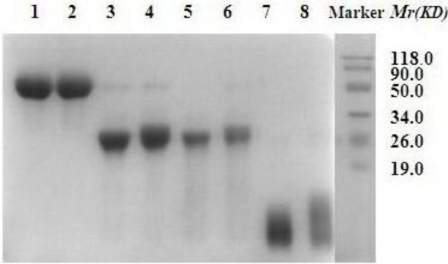
SDS-PAGE analysis of PEGylated HM-3. Lane Marker, Molecular weight markers; Lane 1, SDS-PAGE of SC-mPEG20k; Lane 2, SDS-PAGE of SC-mPEG20k-HM-3; Lane 3, SDS-PAGE of SC-mPEG10k; Lane 4, SDS-PAGE of SC-mPEG10k-HM-3; Lane 5, SDS-PAGE of ALD-mPEG10k; Lane 6, SDS-PAGE of ALD-mPEG10k-HM-3; Lane 7, SDS-PAGE of ALD-mPEG5k; Lane 8, SDS-PAGE of ALD-mPEG5k-HM-3.